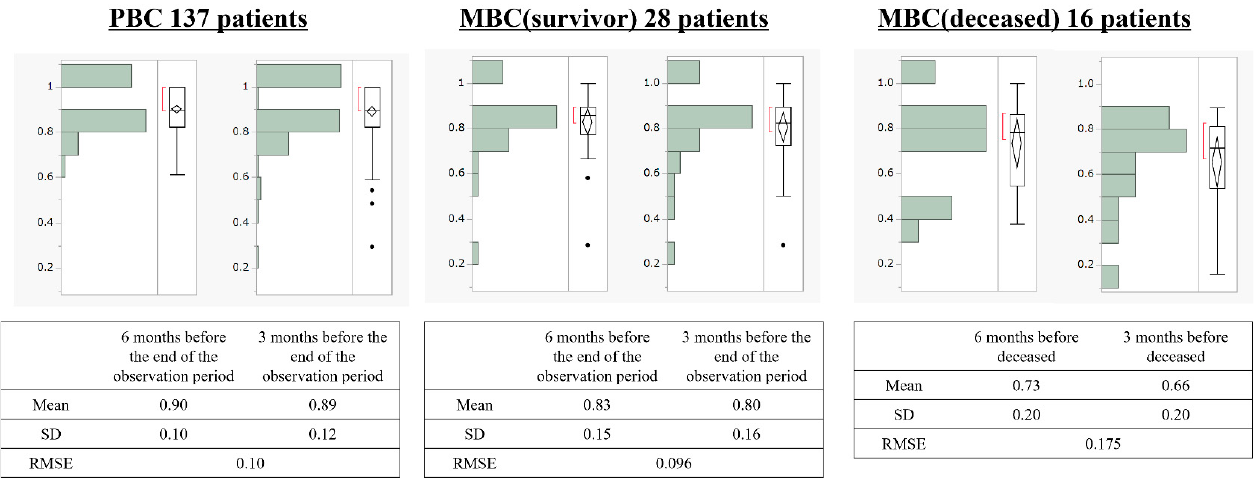
Figure 3 . Transitions of health state utility values in the three groups: MBC, metastatic breast cancer; PBC, primary breast cancer; RMSE, root-mean-squared error; SD, standard deviation. Black dots indicate outliers.